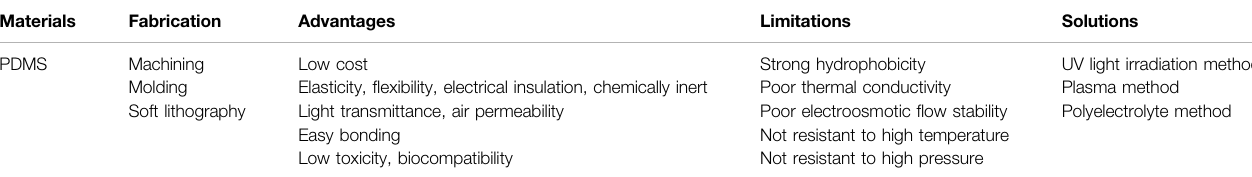
TABLE 1 | Advantages and limitations of PDMS in micro fl uidic